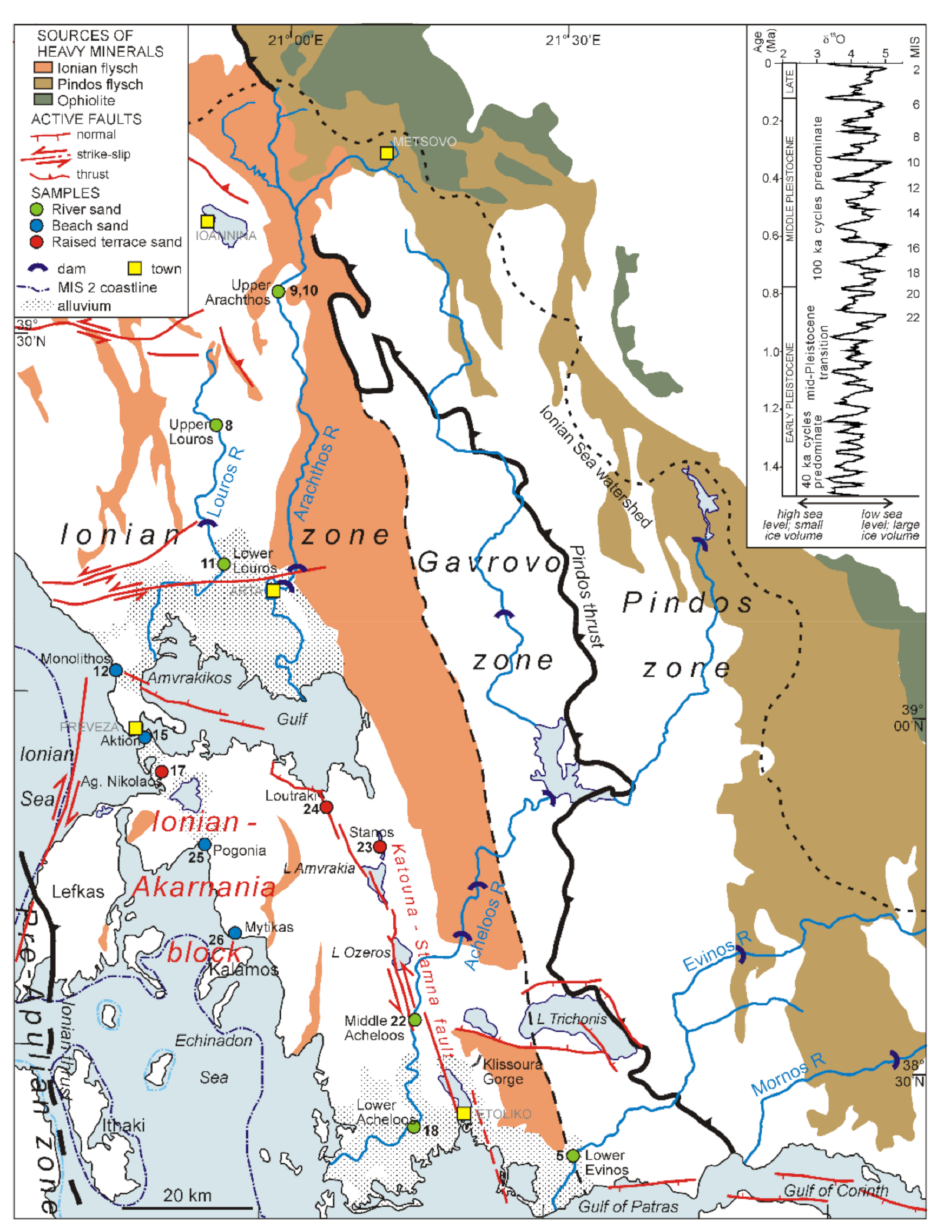
Figure 2. Map showing location of major rivers, sample sites, and principal geological units that are a source of siliciclastic detritus and heavy minerals, and active faults. Base geological map from [16], uncoloured areas are mostly limestone. Active faults from [3,5]. Rivers and dams from [12], Ionian Sea watershed from [17], marine isotope stage (MIS) 2 shoreline from [4,18,19]. Inset shows the Pleistocene global oceanic oxygen isotope curve and the identification of lowstand marine isotopic stages